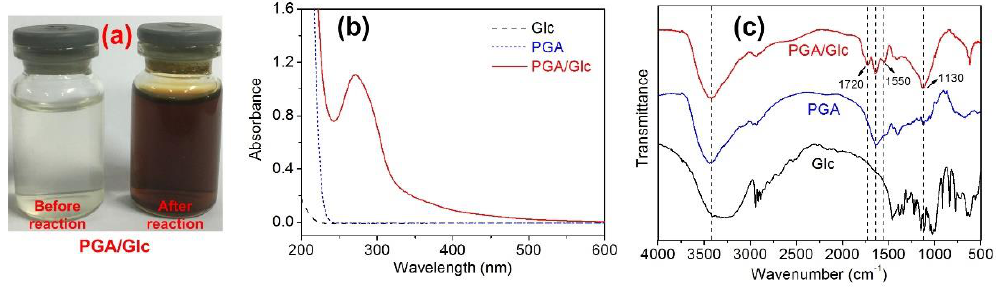
Figure 2. Color ( a ),UV-Vis adsorption spectra ( b ), and FT-IR spectra ( c ) of the PGA/Glc reaction products, PGA and Glc.